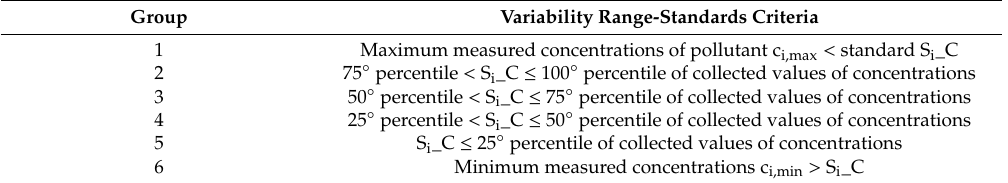
Table 3. Criteria defining the classification of monitored pollutants based on their concentration c i found in this review with respect to the corresponding standard S i _ C defined in the country C ( C = RSA or MZ) reported in Table